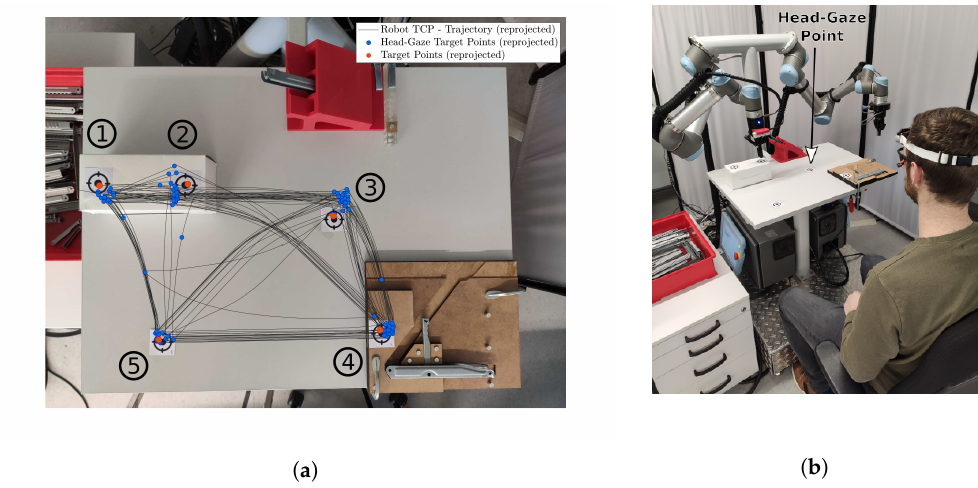
Figure 14. 3D gaze point robot control application. ( a ) depicts the reprojection of the gaze points (blue circles), target points (red circles) and the robots TCP (black line) onto the actual workspace image. ( b ) shows the robot workspace application. A user is sitting in front of the dual arm UR5 robotic system. The user aims for the targets using the head-gaze approach. Upon an eye blink (left eye), the gaze-point is transferred to the robot control pipeline.